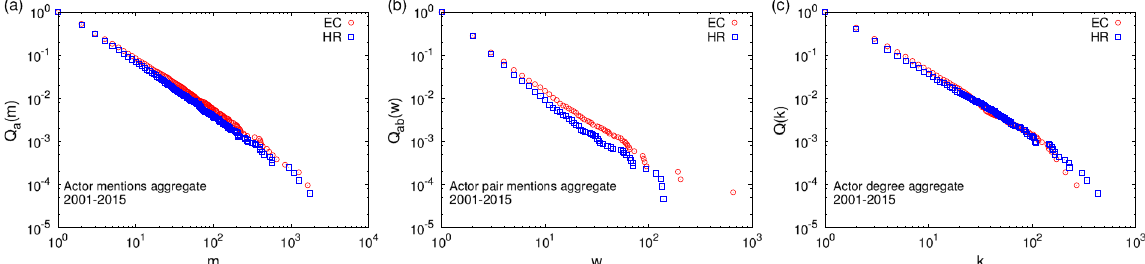
Figure 3. Structural properties of the aggregated network in the period 2001–2015: ( a ) Plot of the cumulative probability (CCDF) Q a ( m ) that an actor is mentioned at least m times. Except for an exponential decay at the very end of the tail, most of the distribution has a the power law decay ∼ ν − Q m m ( )